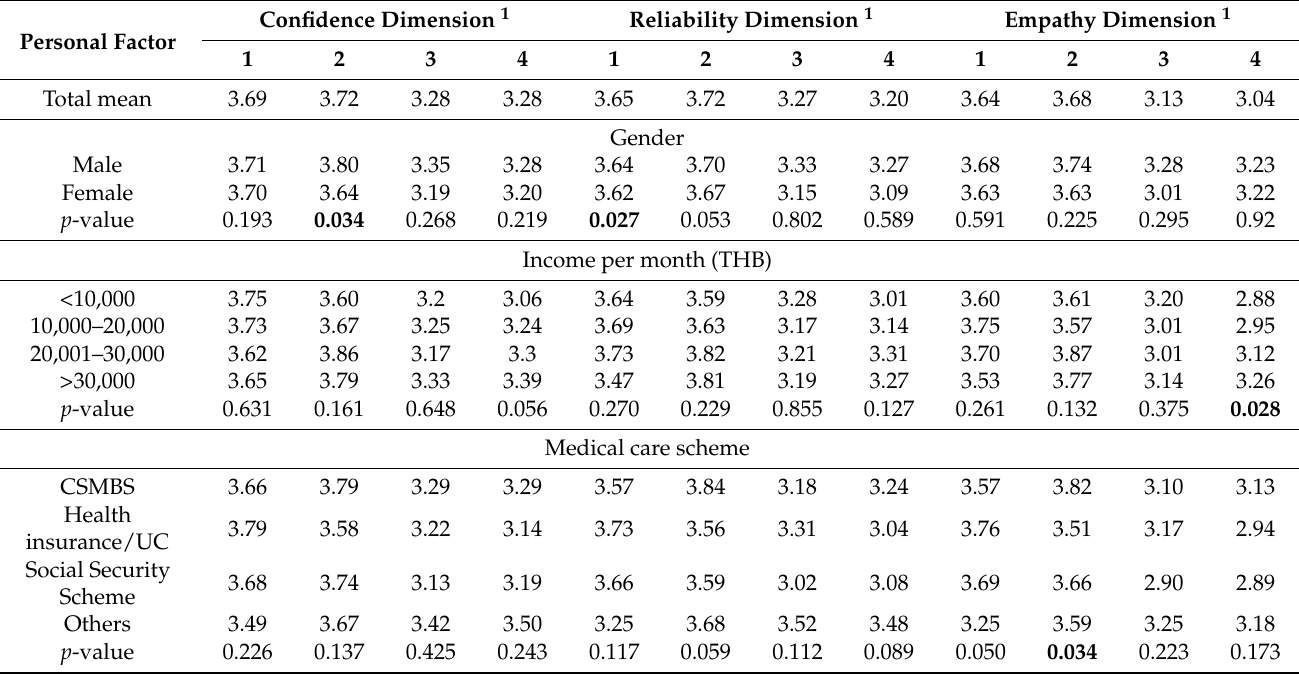
Table 3. The personal factors related to the five attitude scores for medicine delivery methods used by NCD patients ( n =